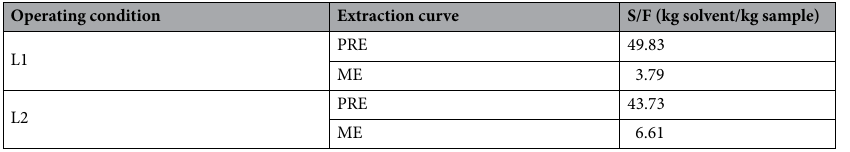
Table 3. S/F values that were maintained from laboratory-scale to larger-scale. PRE is pre-extraction curve and ME is main extraction curve.